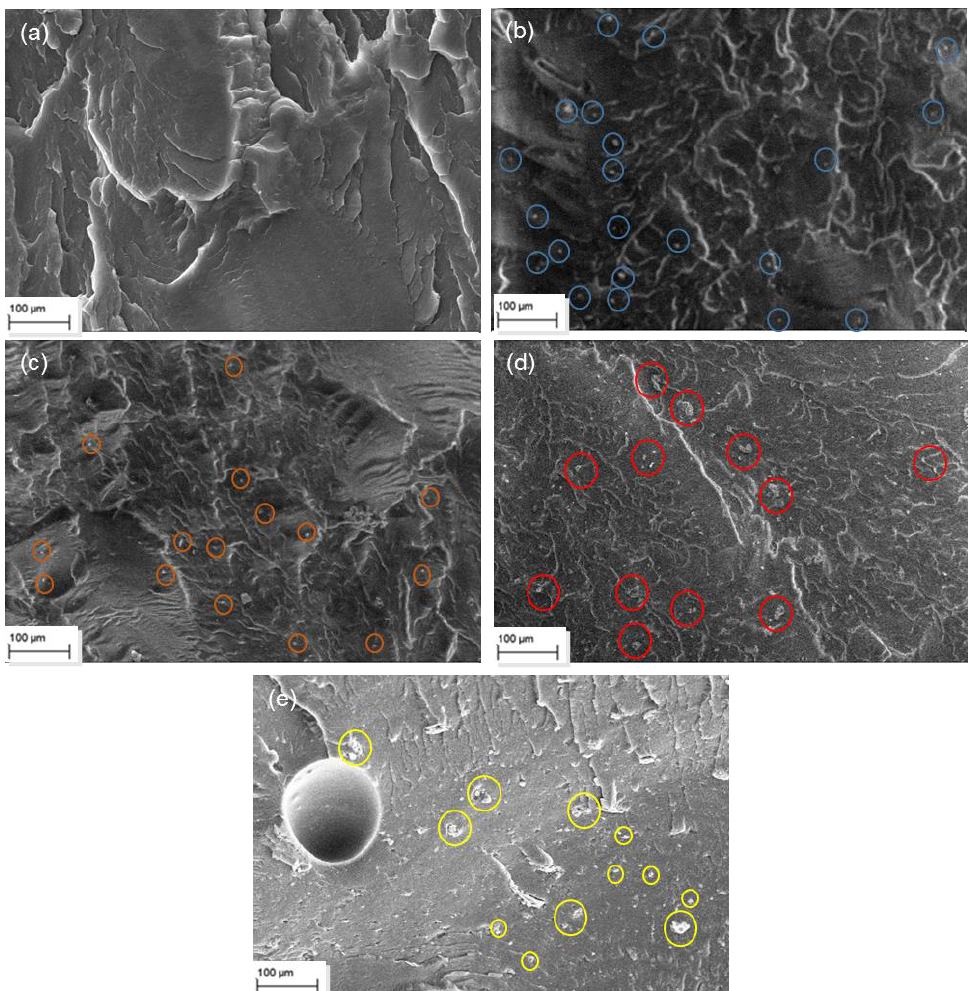
Figure 3. SEM images of ( a ) neat LDPE; ( b ) LDPE with 2.5 wt% MMT; ( c ) LDPE with 5 wt% MMT; ( d ) LDPE with 7.5 wt% MMT and ( e ) LDPE with 10 wt% MMT.